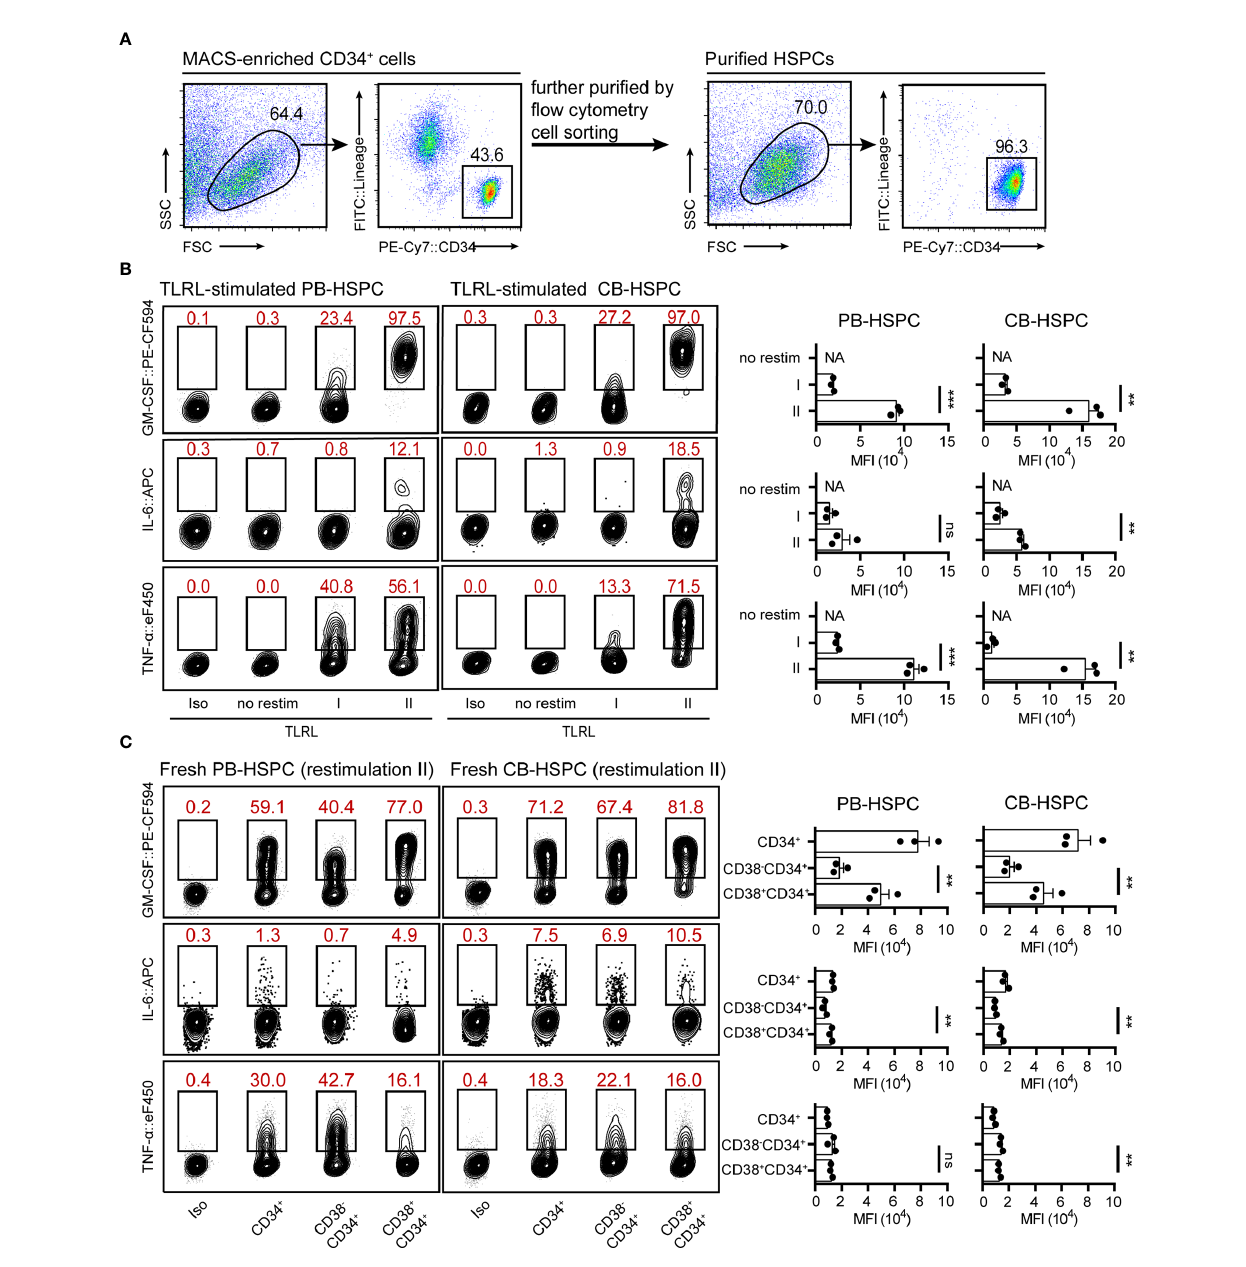
FIGURE 4 | Cytokine expression levels in stimulated and freshly isolated human HSPCs. (A) The gating strategy and the population purity after fl ow cytometry cell sorting. (B) Representative fl ow cytometry plots showing GM-CSF, IL-6 and TNF- a levels in TLRL-stimulated CD34 + cells from PB or CB. To obtain a suf fi cient number of HSPCs, lin - CD34 + cells were fi rst expanded in SFEM supplemented with 50 ng/ml SCF. On day 3, these cells were exposed to LPS and Pam3CSK4 for 12 h, and then cells were harvested for fl ow cytometry analysis (with restimulation II). The data refer to a typical experiment out of three that generated similar results. ** P < 0.01, *** P < 0.001; ns, not signi fi cant, by Student ’ s t test. (C) Representative fl ow cytometry plots showing GM-CSF, IL-6 and TNF- a levels in freshly isolated human blood-derived HSPCs ( n = 3 per group). Cells isolated from fresh blood were treated with restimulation II before fl ow cytometric analysis. The data refer to a typical experiment out of three that generated similar results. ** P < 0.01; ns, not signi fi cant, by 1-way ANOVA followed by Tukey ’ s test. The numbers in the fl ow cytometry plots indicate the proportions of gated cells. APC, allophycocyanin; eF450, eFluor 450; FITC, fl uorescein isothiocyanate; NA, not